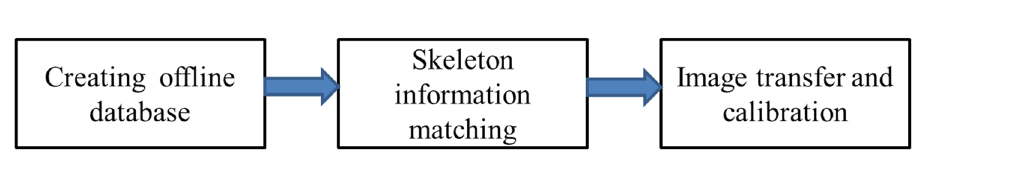
Figure 3. Flow of clothing transfer